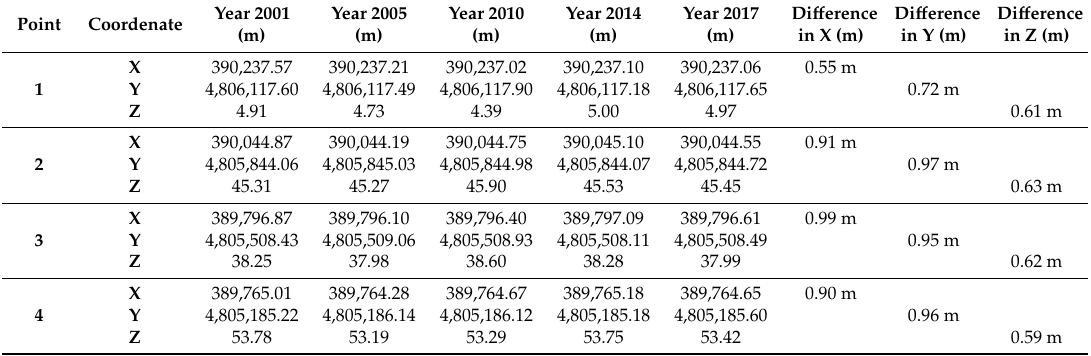
Table 1. Check points measured in the photogrammetric models of the di ff erent flights. Measured coordinates and maximum di ff erences to ground measured points. Maximum di ff erence of